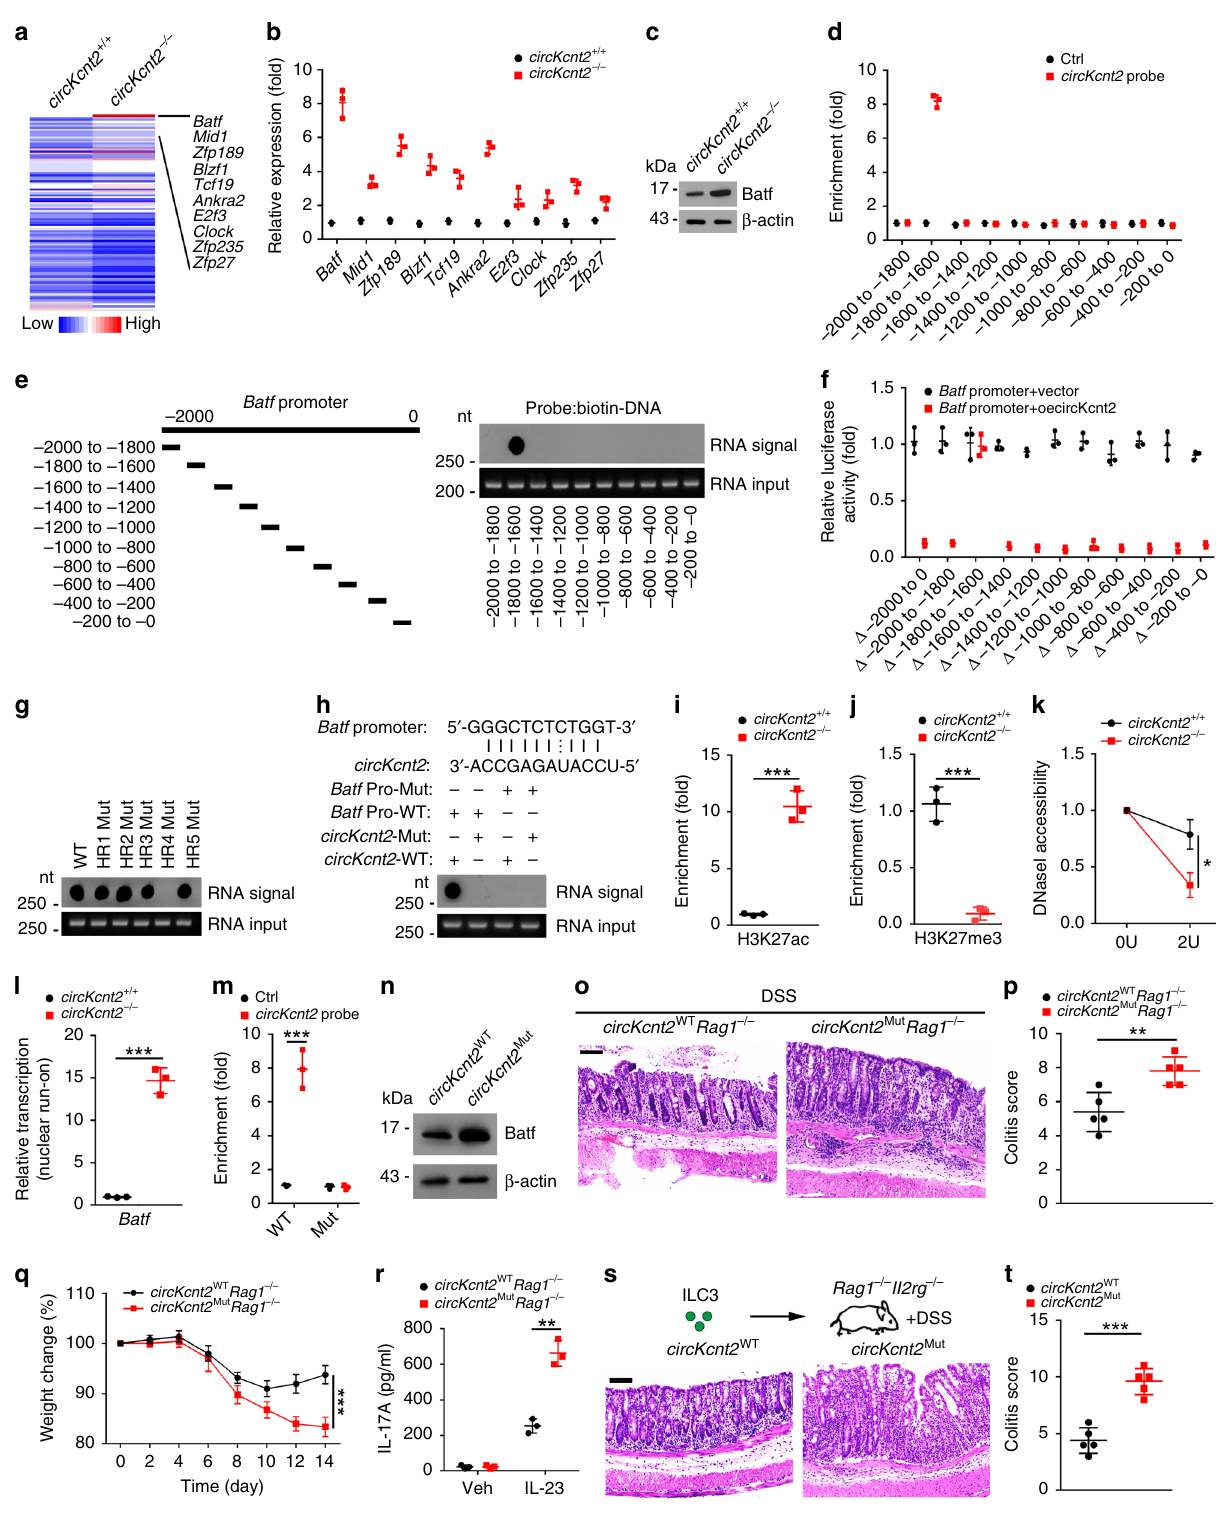
(Supplementary Fig. 4h). We observed that circKcnt2 mutation abrogated the enrichment of circKcnt2 onto Batf promoter (Fig. 3m), and consequently enhanced Batf expression in ILC3s with DSS treatment (Fig. 3n). We then treated circKcnt2 WT Rag1 − / − and circKcnt2 Mut Rag1 − / − mice with DSS. We noticed that circKcnt2 Mut Rag1 − / − mice displayed much more severe innate colitis compared to circKcnt2 WT Rag1 − / − mice (Fig. 3o –